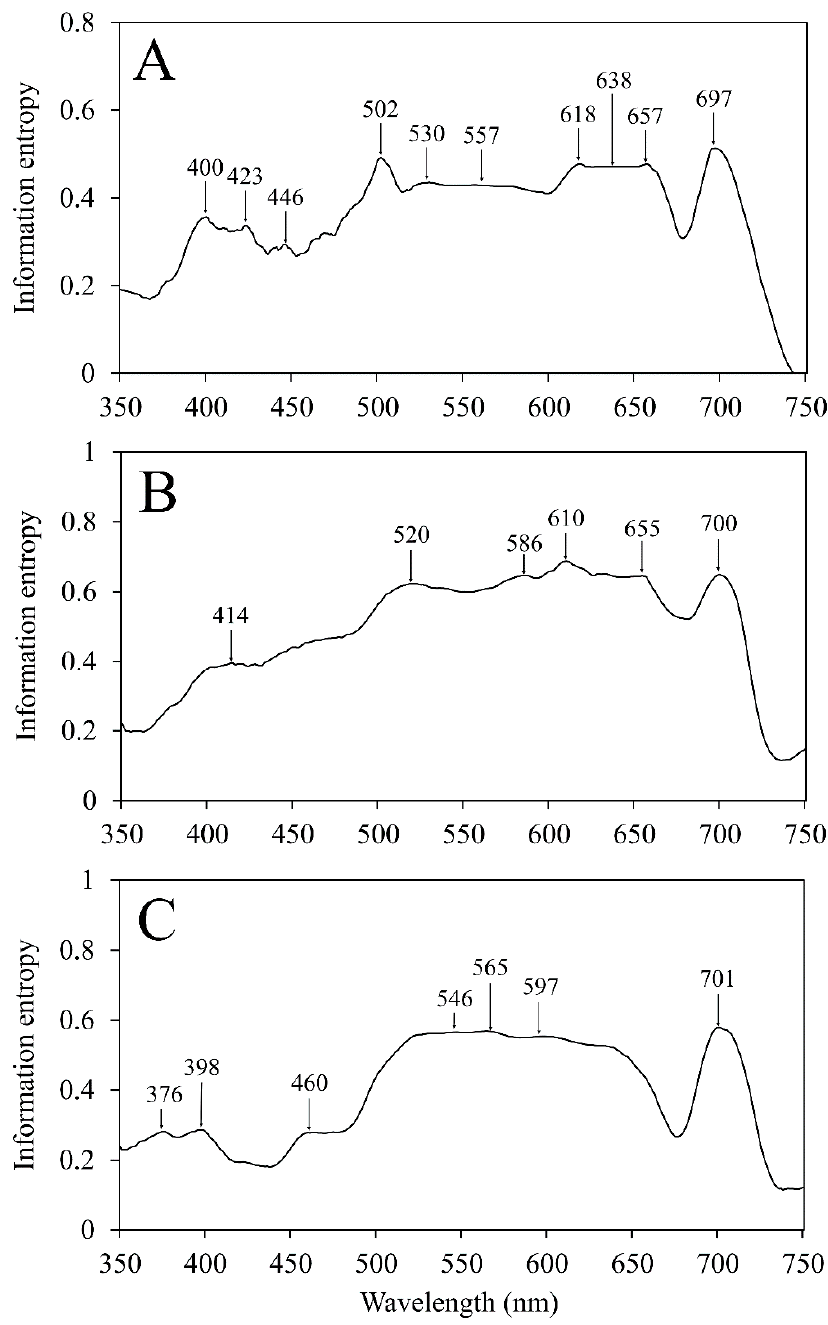
Figure 3. Savitzky–Golay-filtered information entropy observed among ( A ) young, ( B ) intermediate, and ( C ) mature flue-cured tobacco ( Nicotiana tabacum L.) plants. Peak wavelengths demonstrate locations with the most informative bands necessary to distinguish among each nutrient deficiency.